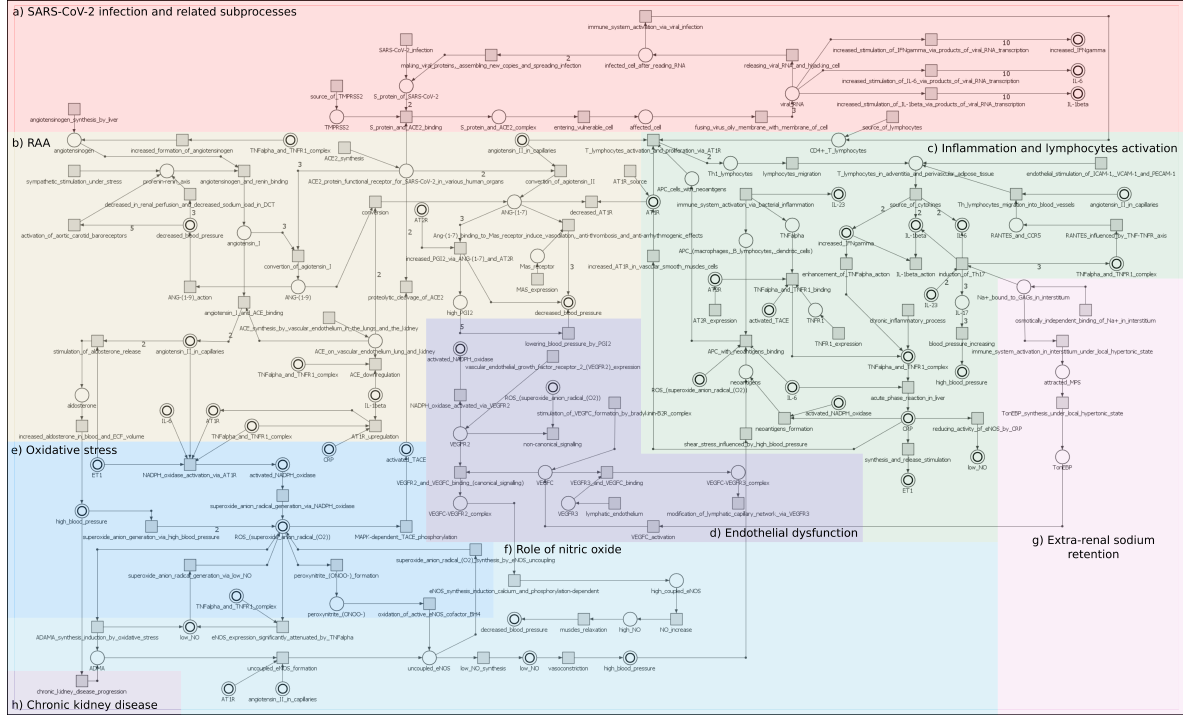
Figure 1. Model of the relation between SARS-CoV-2 infection and essential hypertension with division into particular modules.